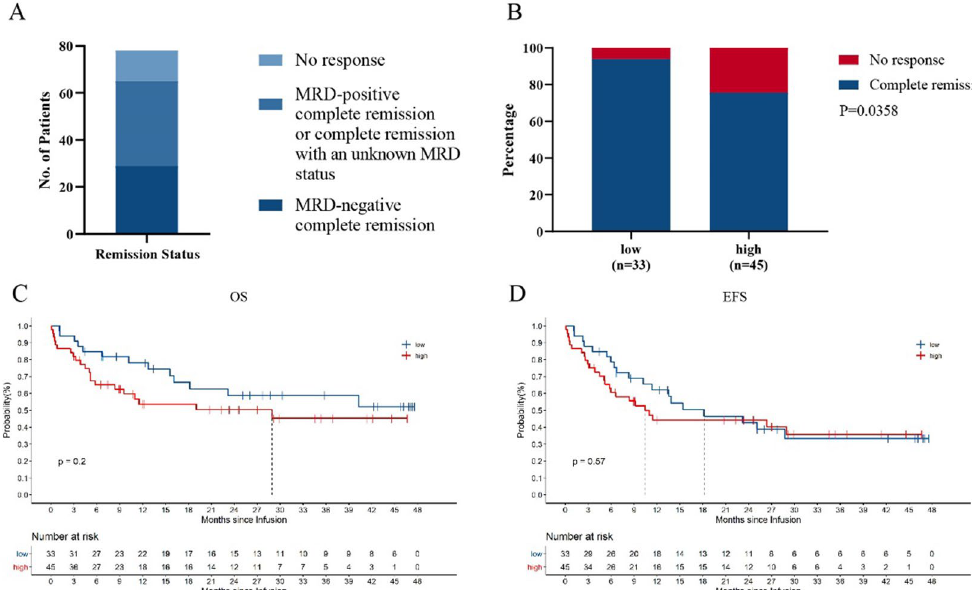
Figure 2. Response to ssCART-19 cells. ( A ) The rates of minimal residual disease (MRD)-positive complete remission, MRD-negative complete remission and no response. Patients with an unknown MRD status were included with those who achieved MRD-positive complete remission. ( B ) Correlation between the remission status and tumor burden ( P = 0.0358; Fisher’s exact test). ( C, D ) Kaplan–Meier analyses demonstrated better OS and EFS rates in patients who had a low tumor burden (blue line, n = 33) than in those who had a high tumor burden (red line, n = 45; P = 0.2 and P = 0.57, respectively; log-rank